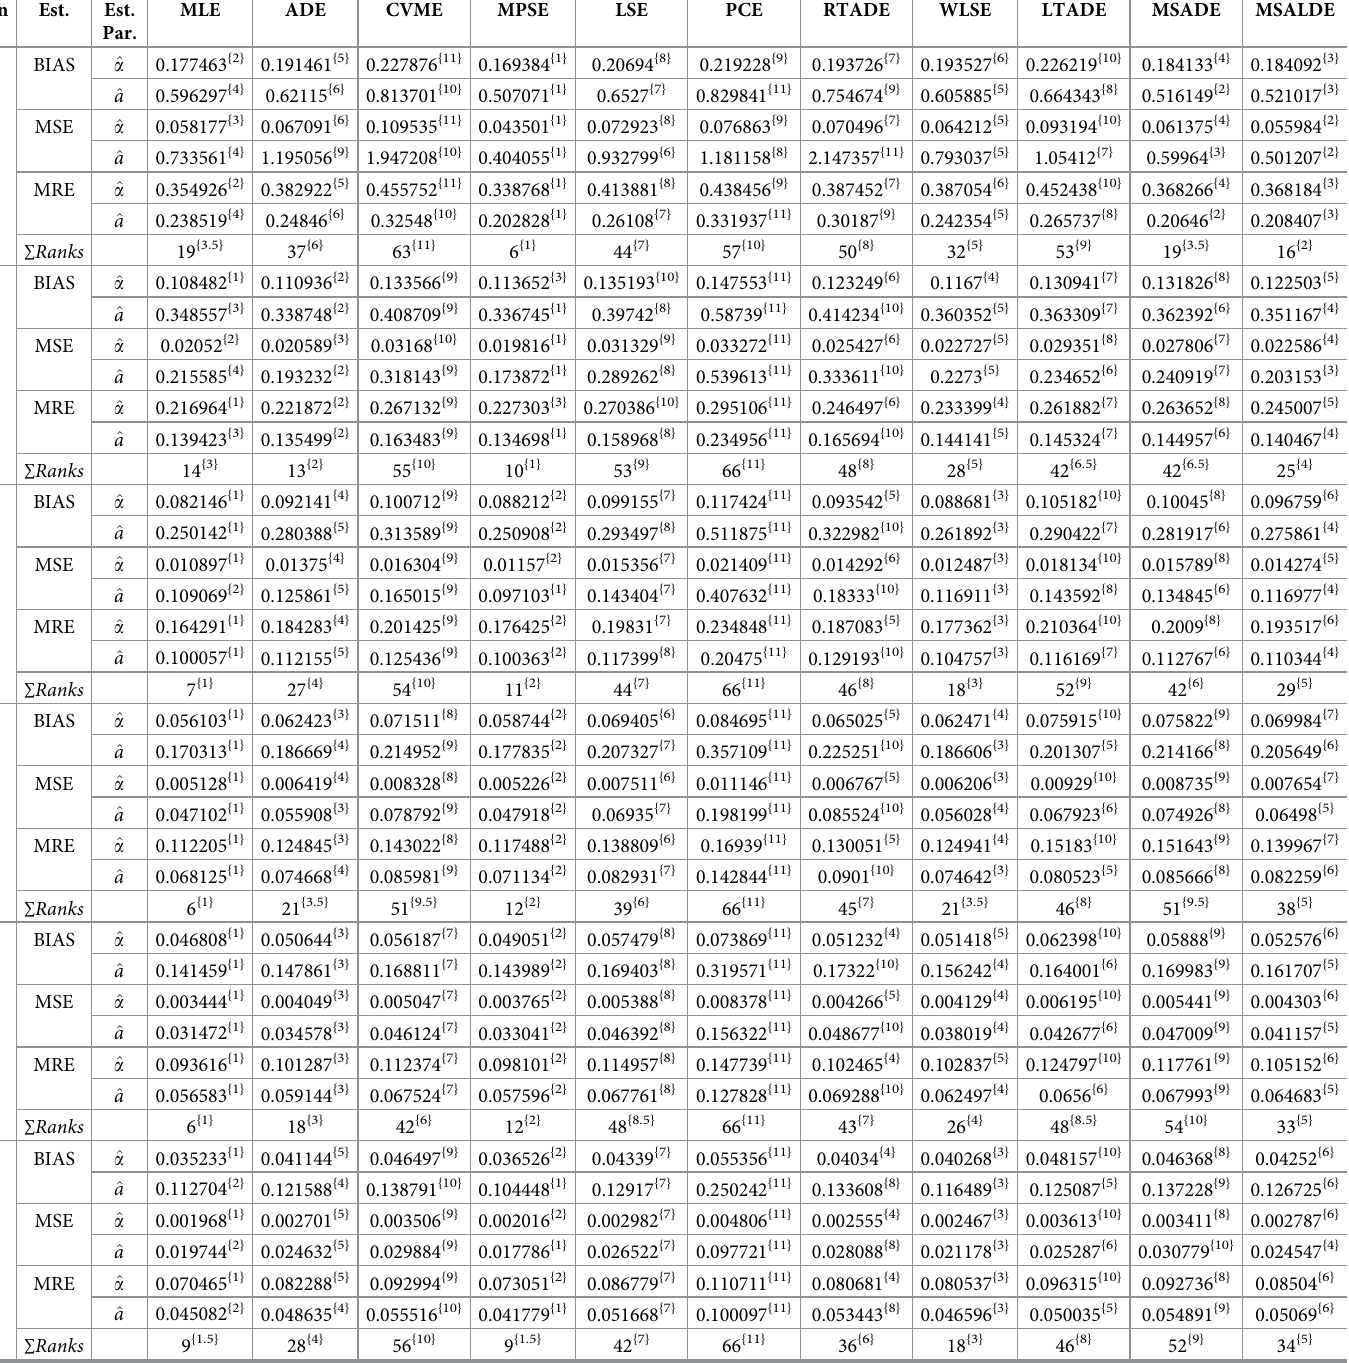
Table 4. Simulation values of BIAS, MSE and MRE for ( α = 0.5, a = 2.5). n